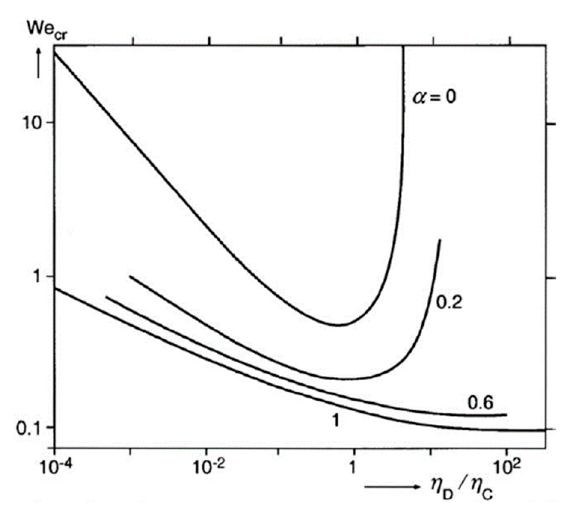
Figure 6. Critical We-numbers (We cr ) for laminar flow conditions—plain shear flow (upper curve), and for extensional flow (lower curve) ([41,42]). η D / η C is the ratio of the dispersed phase viscosity over the continuous phase viscosity. Re-printed with permission from author Walstra.